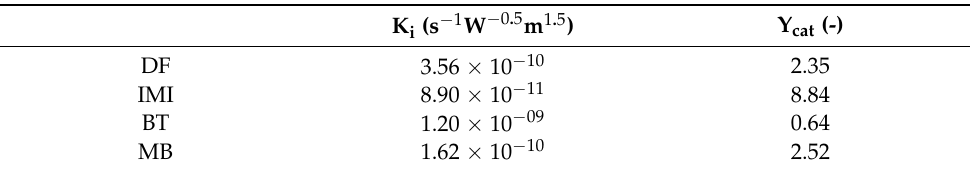
Table 1. Intrinsic degradation rate constants for DF, MI, BT and MB along with the intensification factors due to TiO 2 modification with